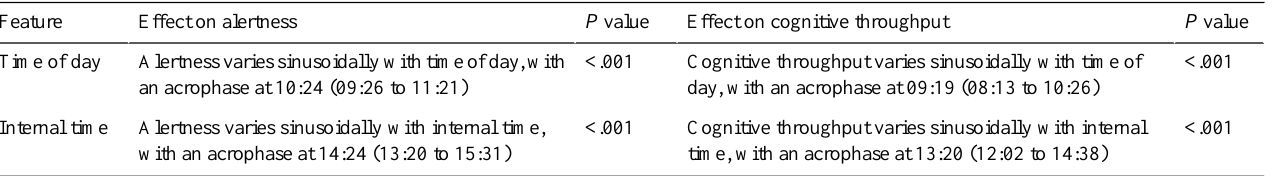
P valueEffect on cognitive throughput P valueEffect on alertnessFeature